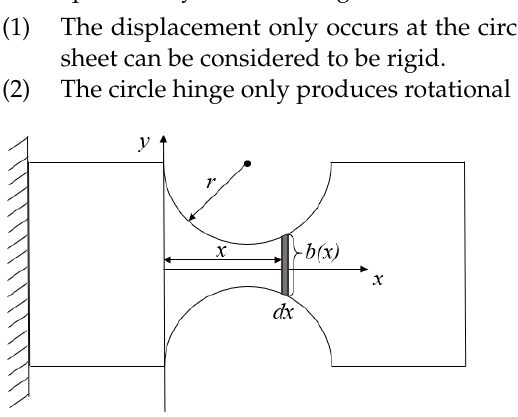
Figure 6. The micro-element of circle hinge.